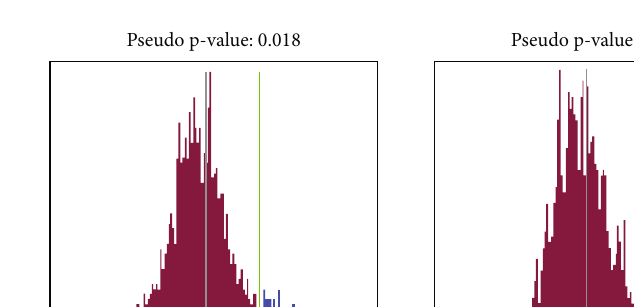
Figure 3: Global Moran index results for six types of weather.